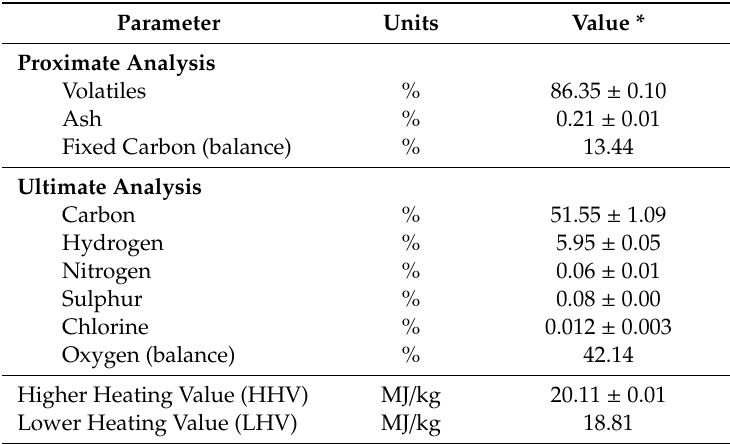
Table 1. Fuel characteristics of the biomass ( Pinus radiata